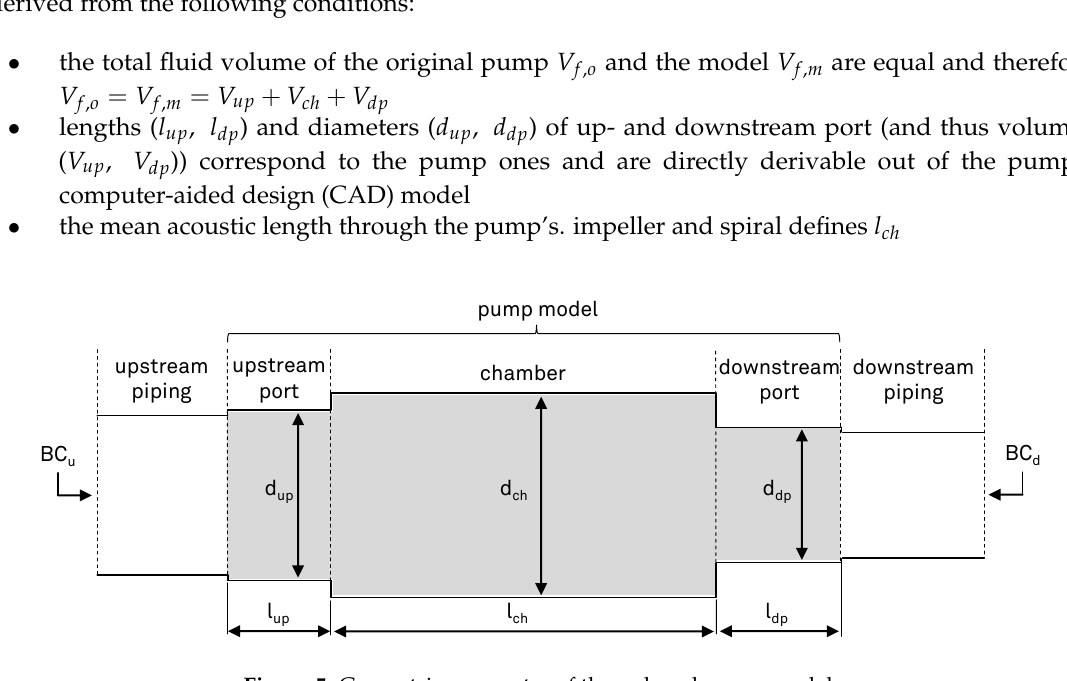
Figure 5. Geometric parameter of the reduced pump